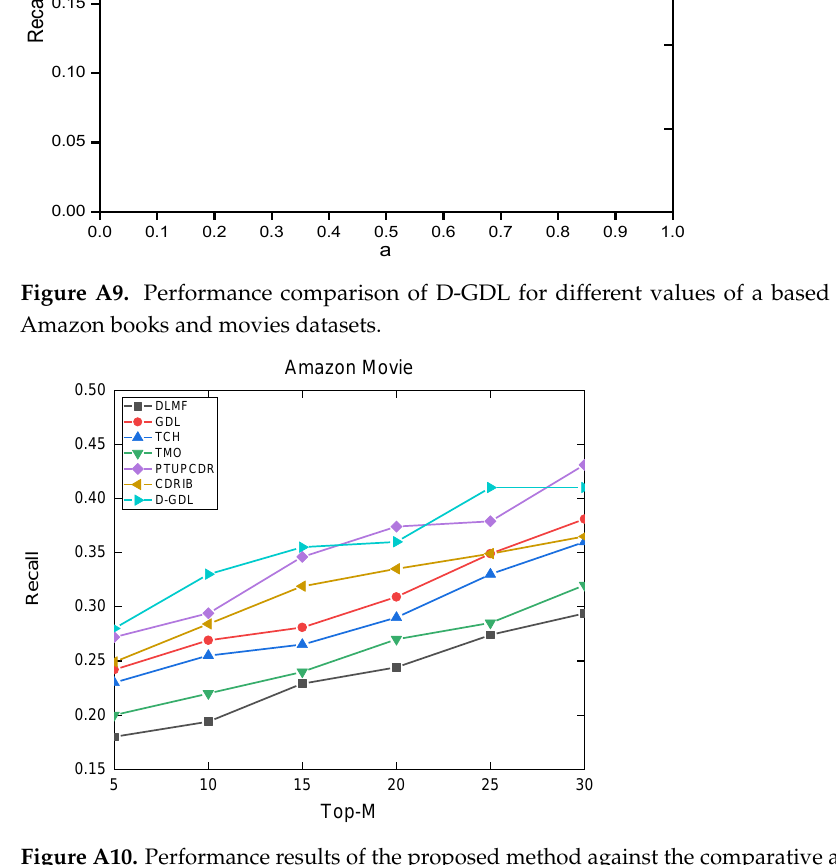
Figure A10. Performance results of the proposed method against the comparative approaches based on Recall for the Amazon movie dataset.